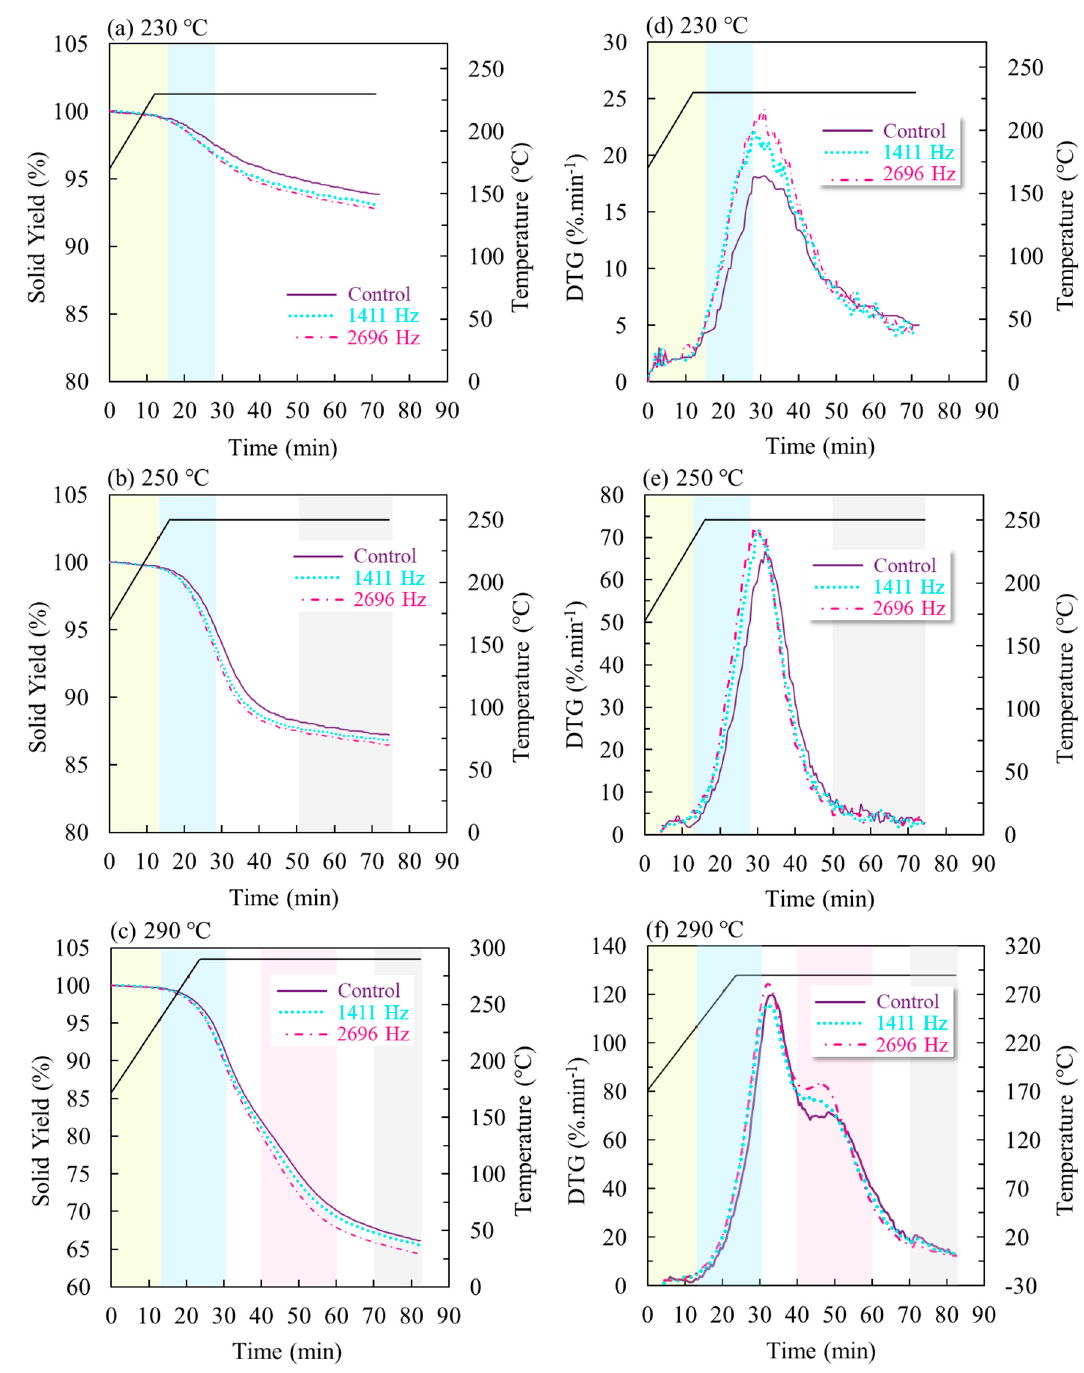
Figure 2. Thermogravimetric (TG) and deviation of thermo-gravimetric (DTG) profiles of thermoacoustic torrefaction for control, 1411, and 2696 Hz under ( a , d ) 230, ( b , e ) 250, and ( c , f ) 290 °C temperature treatments.